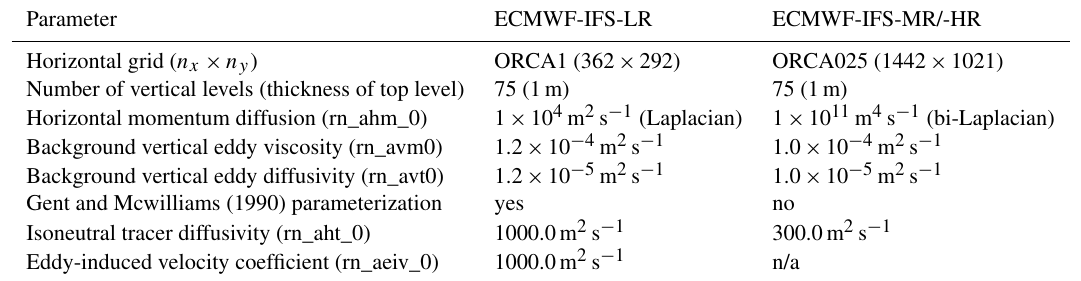
Table 1. Differences in the NEMO ocean model configurations used in ECMWF-IFS-LR and ECMWF-IFS-MR/-HR. n/a: not applicable.